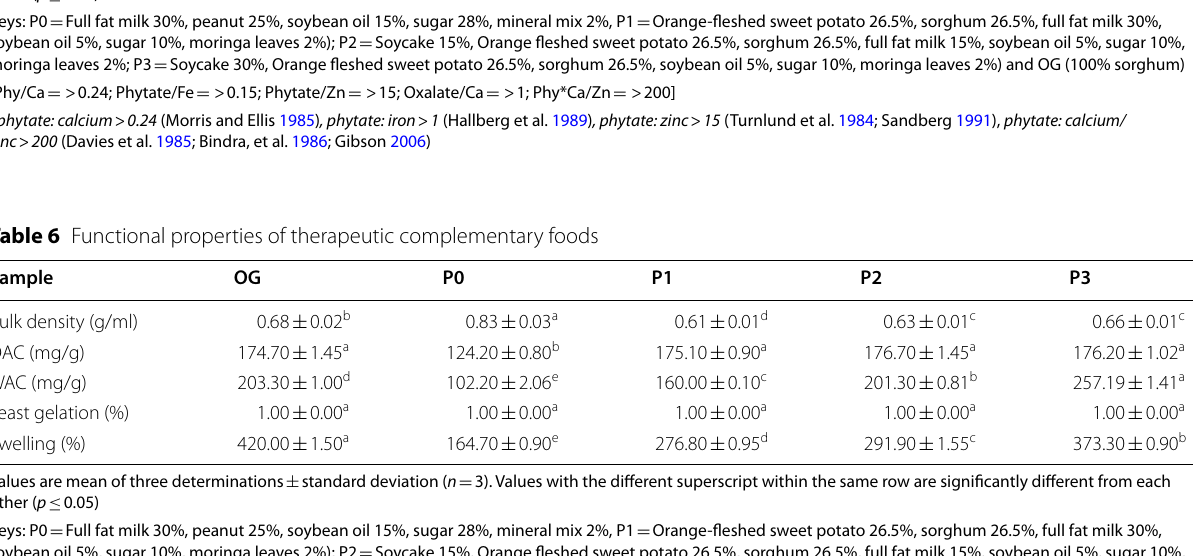
Values are mean of three determinations standard deviation ( n 3). Values with the different superscript within the same row are significantly different from each ± = other ( p 0.05) ≤ Keys: P0 Full fat milk 30%, peanut 25%, soybean oil 15%, sugar 28%, mineral mix 2%, P1 Orange-fleshed sweet potato 26.5%, sorghum 26.5%, full fat milk 30%, = = soybean oil 5%, sugar 10%, moringa leaves 2%); P2 Soycake 15%, Orange fleshed sweet potato 26.5%, sorghum 26.5%, full fat milk 15%, soybean oil 5%, sugar 10%, = moringa leaves 2%; P3